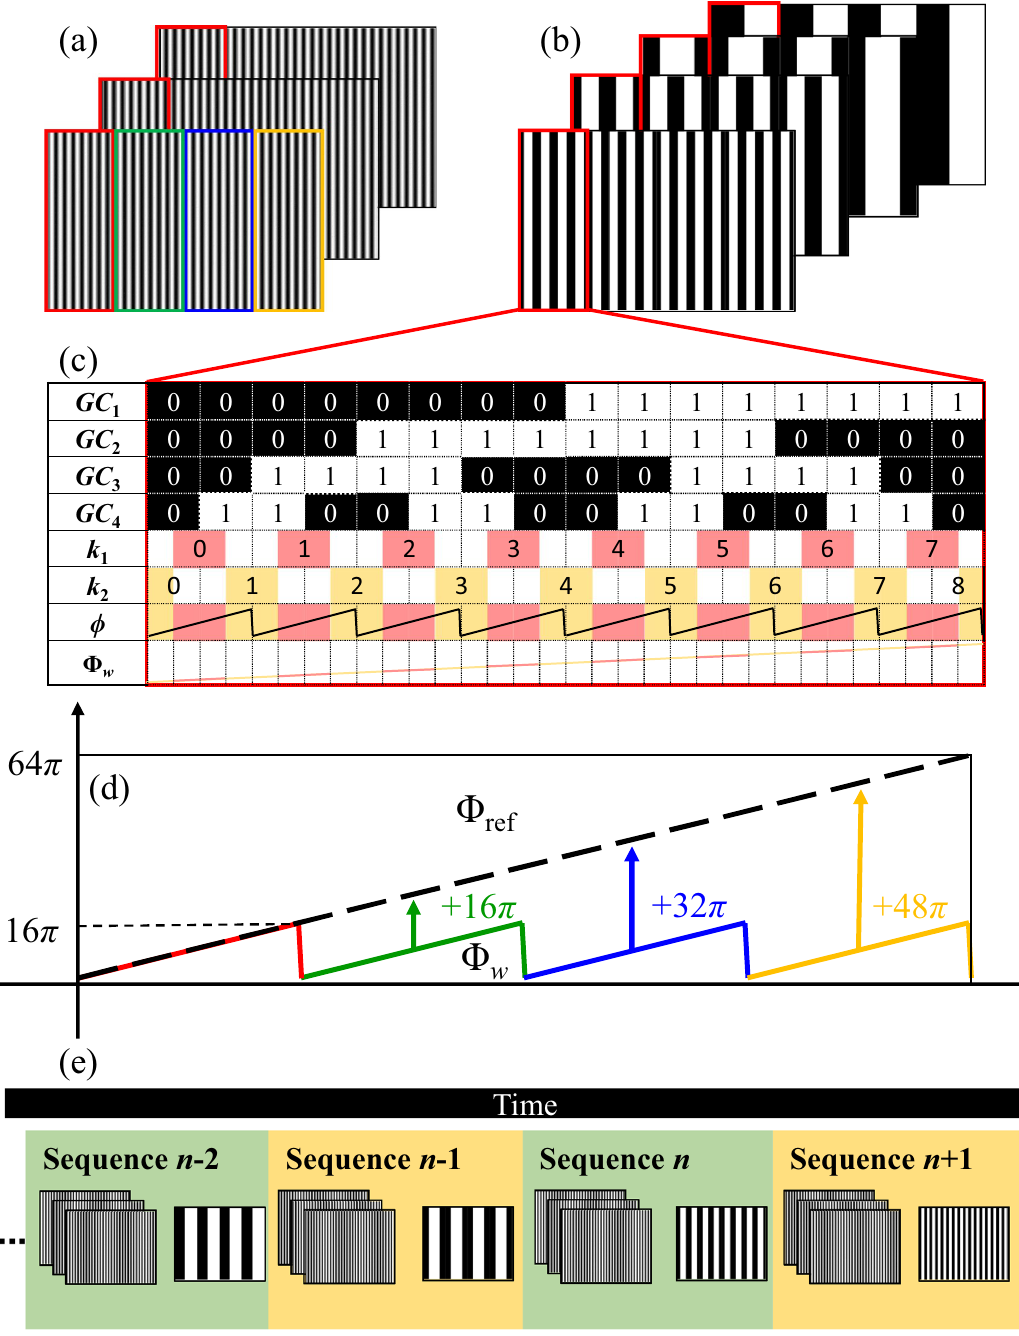
Figure 2. Principle of the robust and efficient 3D shape measurement based on Gray-coded-based method. ( a ) Projected phase shifting patterns. ( b ) Projected Gray code patterns. ( c ) Decoding process using complementary strategy. ( d ) Period extension based on reference phase. ( e ) Efficiency improvement using time-overlapping coding